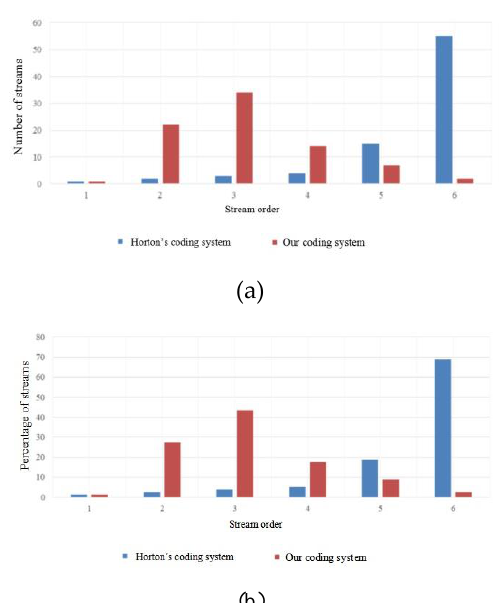
Figure 6. Comparison between Horton’s coding system and our coding system in terms of the number of streams corresponding to each stream order: (a) a histogram comparing two hydrologic coding systems in terms of the number of streams corresponding to each stream order and (b) a histogram comparing two hydrologic coding systems in terms of the percentage of streams corresponding to each stream order Although both stream coding systems result in the identification of one main stem, there are significant differences in the number of streams corresponding to each stream order, as shown in Table 1 and Fig. 6. In the Horton system, the number of streams decreases with stream order; first-order tributaries around the boundaries of the river system (i.e., the locations of river sources) account for 66.27% of all streams, which exceeds the sum of streams from all other stream orders. The distribution of streams corresponding to our coding system exhibits a bell curve (i.e., lower and higher order streams are fewer in number, whereas medium-order streams are greater in number), which is caused by differences in the identification of source tributaries